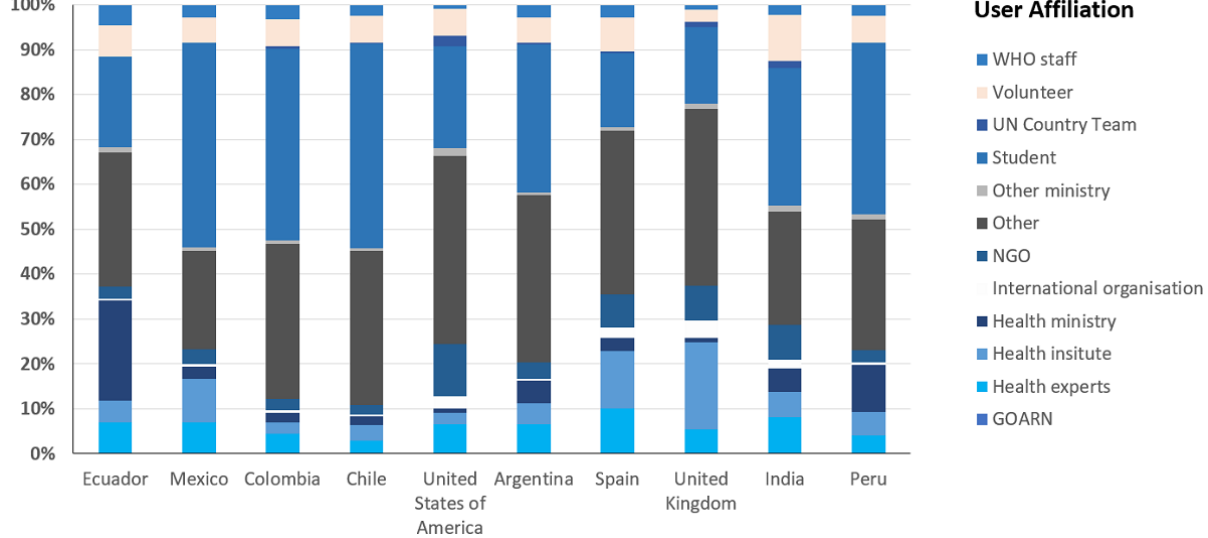
Figure 5. Users from the top 10 countries and their affiliations. GOARN: Global Outbreak Alert and Response Network; NGO: nongovernmental organization; WHO: World Health